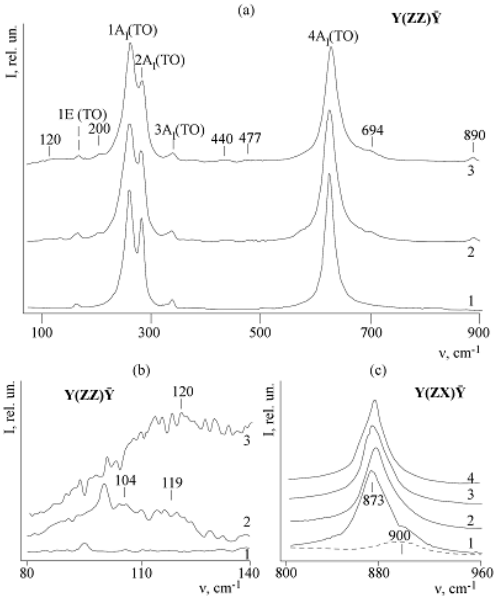
Figure 18. Raman spectra of LN single crystals in the scattering geometry Y(ZZ) Ȳ : ( a ) a general curve of the Raman spectra: 1 - SLN; 2 - CLN; 3 - LiNbO 3 :Zn (5.84 mol.% ZnO). Extra band are marked with arrows. ( b ) fragments of the Raman spectrum of LN crystals in the region of 80 – 140 cm – 1 : 1 - SLN; 2 - CLN; 3 - LiNbO 3 :Zn (5.84 mol.% ZnO). ( c ) fragments of the Raman spectrum of LN crystals in the frequency region of stretching bridge vibrations Nb-O-Nb in the Y(ZX) Ȳ geometry: 1 - LiNbO 3 :Er